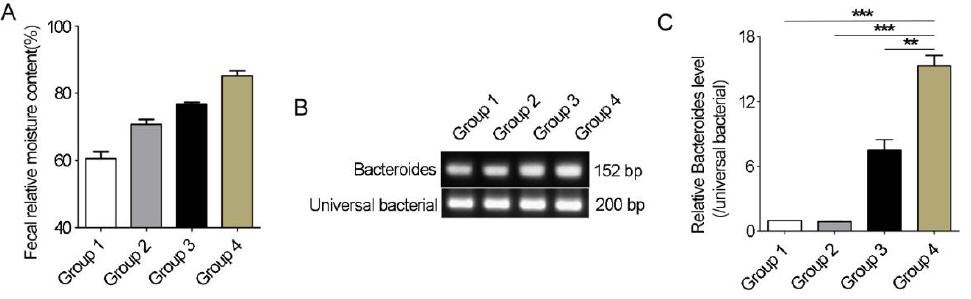
Figure 7. Bacteroides abundance comparison in feces of Père David’s deer with or without diarrhea. ( A ) 15 feces samples from non-diarrhea individuals were collected from semi-wide and wild areas and divided into 3 groups ( n = 5/group) based on relative moisture content. Group 4 was diarrhea feces samples ( n = 5). ( B ) Conventional PCR was used to amplify Bacteroides -specific fragment. ( C ) qRT-PCR was used to compare the Bacteroides abundance in Père David’s deer feces with or without diarrhea. Data were presented as the mean ± SEM. ** p < 0.01, *** p < 0.001.